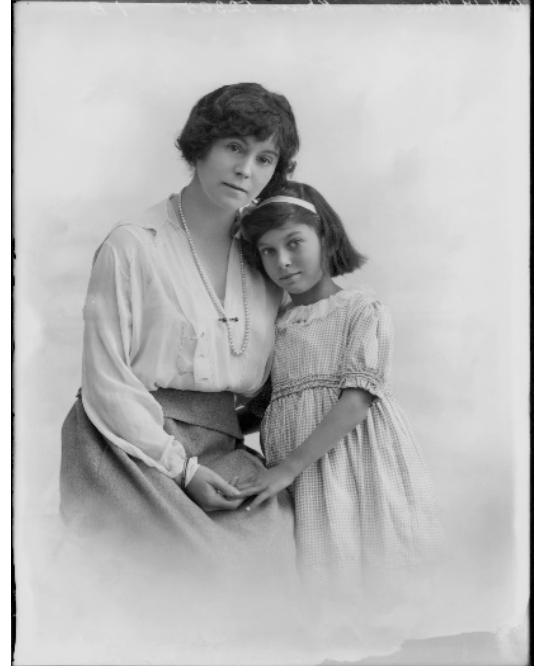
Figure 10. Dolly Parnell (Princess Nasir Ali Khan) with her daughter Betty Naldera Ali Khan, 1918. Dolly Parnell, an actress, married Prince Nasir Ali Khan, a brother of the Muslim Nawab of Rampur, India, in London 1909. Their daughter, Betty, was born three years later. After their marriage, the couple lived in St John’s Wood, London for a number of years before relocating to the south of France. © National Portrait Gallery.